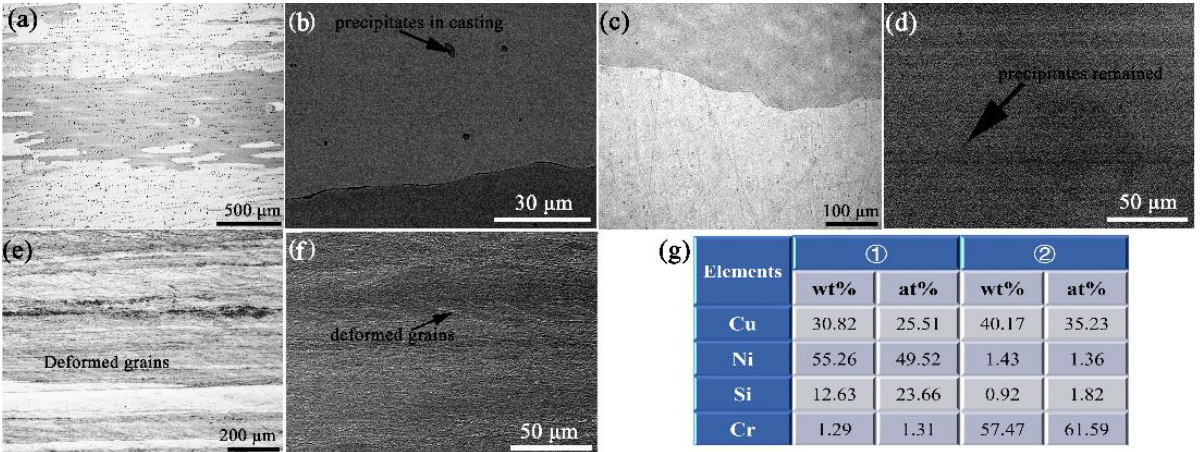
Figure 3. The evolution of microstructures of the Cu-Ni-Si alloy during the fabrication process, con- taining SEM photographs of ( a ) HCCM casting, ( b ) the magnified casting microstructure, ( c ) solu- tion treated, ( d ) the magnified solution treated microstructure, ( e ) cold rolling, ( f ) magnified cold rolling microstructure, and ( g ) the EDS data of the position marked in ( a , b ).